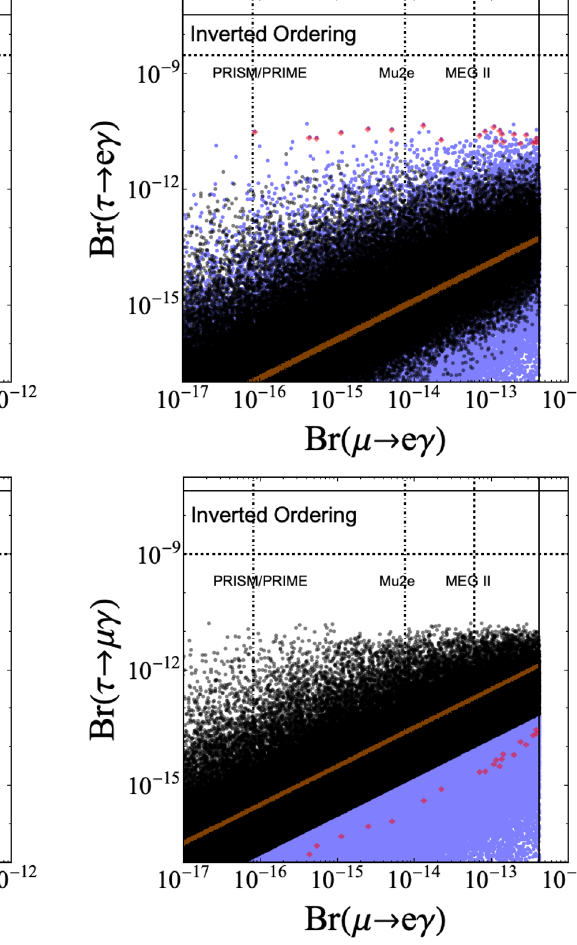
Figure 5 . Branching ratios of radiative charged-lepton decays. The vertical dot-dashed lines correspond to the prospected sensitivities to Br ( µ → e ; Ti ) at PRISM/PRIME and to Br ( µ → e ; Al ) at Mu2e which were then converted via Br ( µ → e ; Al ) ≈ 0 . 0079 Br ( µ → eγ ) and Br ( µ → e ; Ti ) ≈ 0 . 0125 Br ( µ → eγ ) , see also appendix C. The colours are the same as in figure